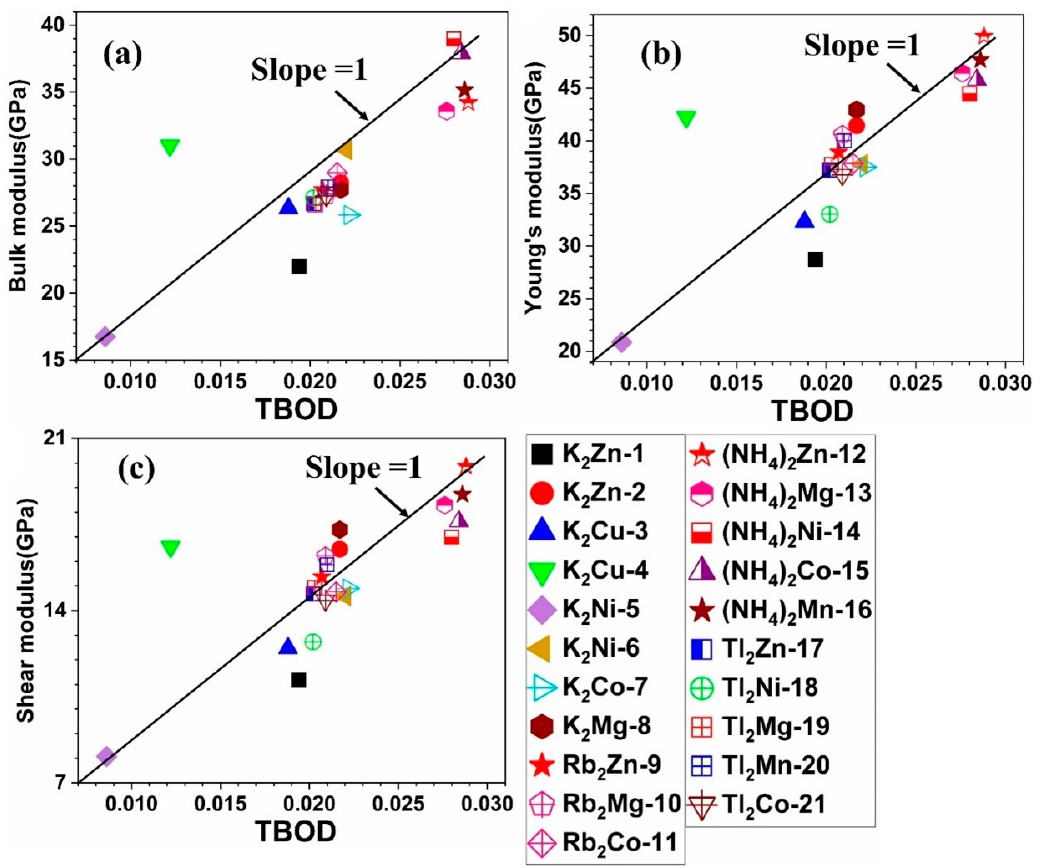
Figure 6. Distribution of bulk modulus ( a ), Young’s modulus ( b ), and shear modulus ( c ) versus TBOD for the 21 crystals.